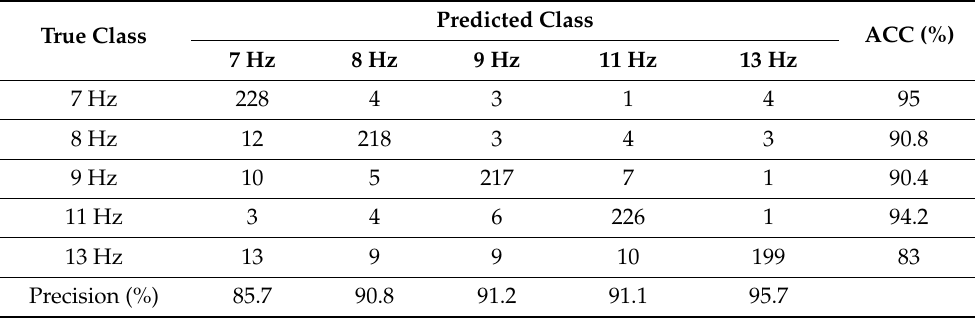
Table 1. The confusion matrix for the SSVEP recognition results using CCA classifier for the direction test in the first experiment (Scenario 1).